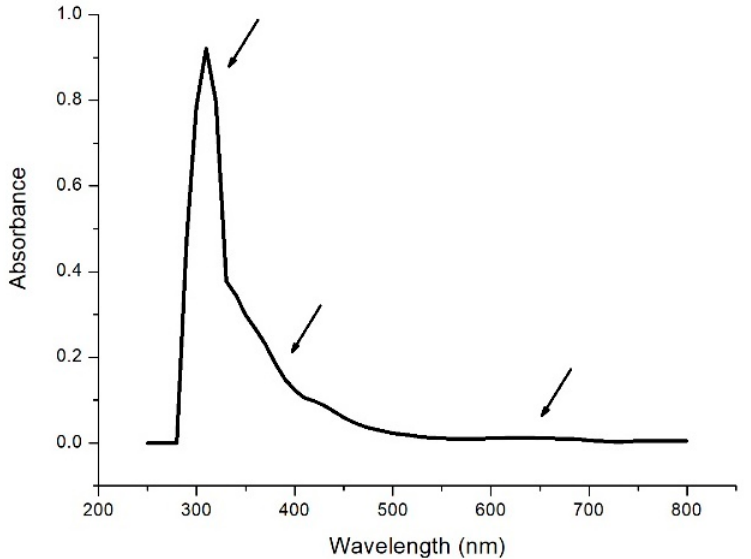
Figure 1. Absorption spectrum [Laccase T. Versicolor ] = 8 µ g/mL in 0.1 M acetate buffer at pH 5.0. Arrows indicate the presence of the peaks at 310 nm, 330 nm, and 650 nm, respectively.